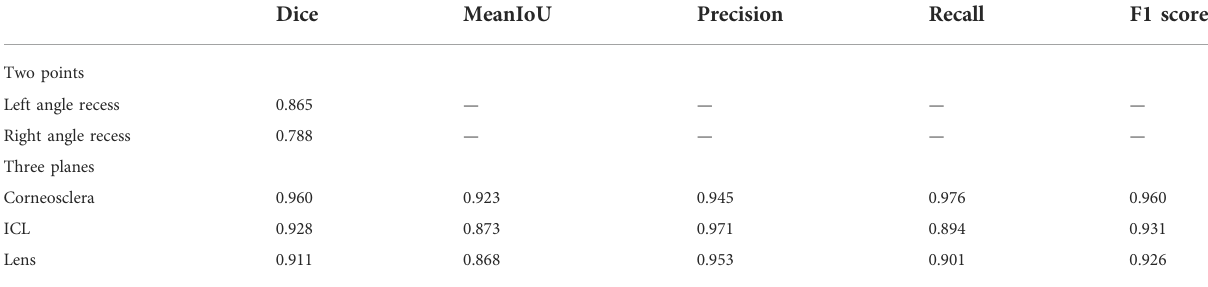
TABLE 1 The segmentation performance of the structures in AS-OCT following ICL implantation.